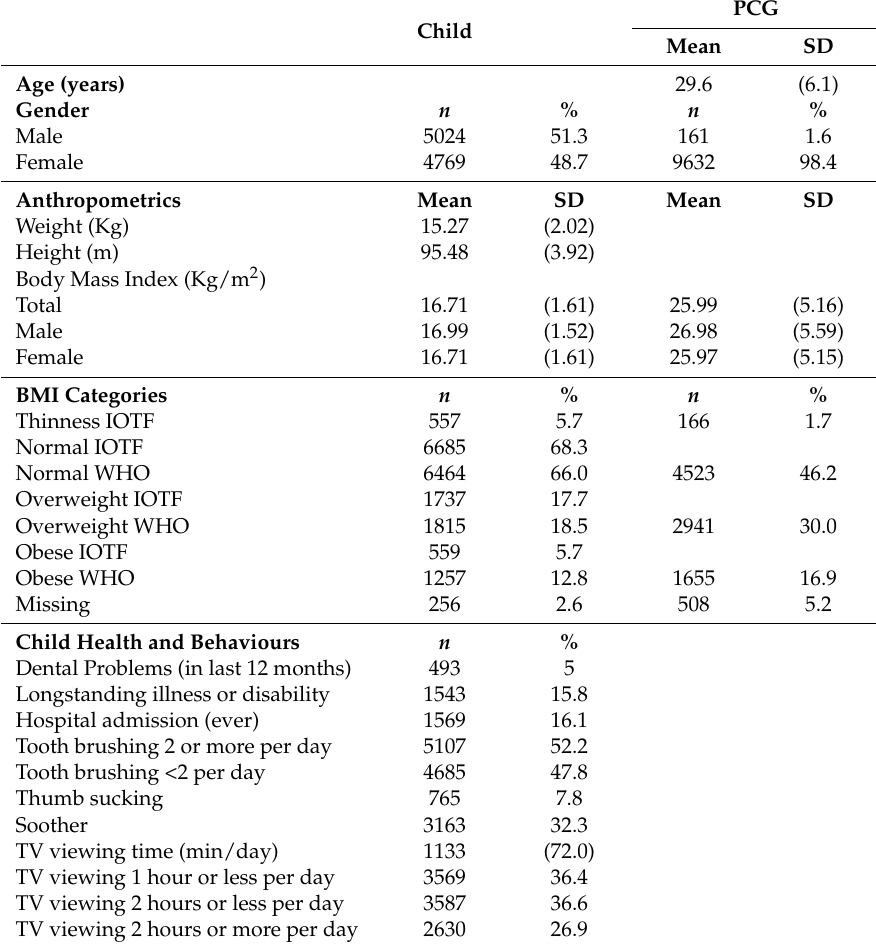
Table 1. Weighted a Sample Characteristics, Growing Up in Ireland infant cohort participants 2010/11 (Child 3-years of